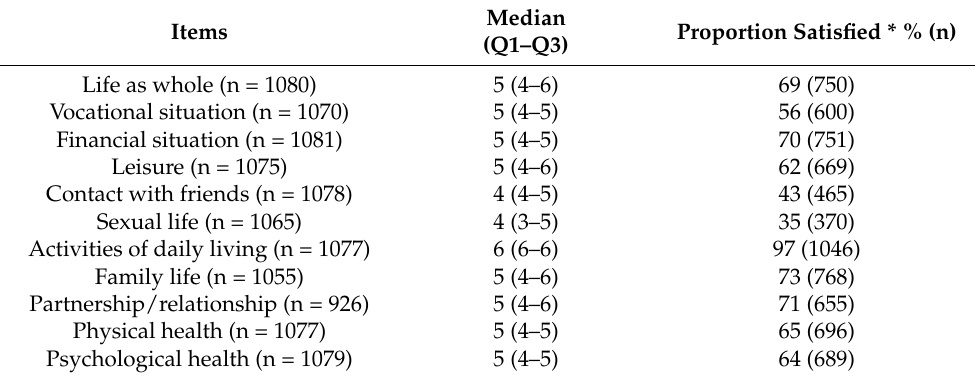
Table 2. LiSat-11 scores presented as median (Q1–Q3) and proportion